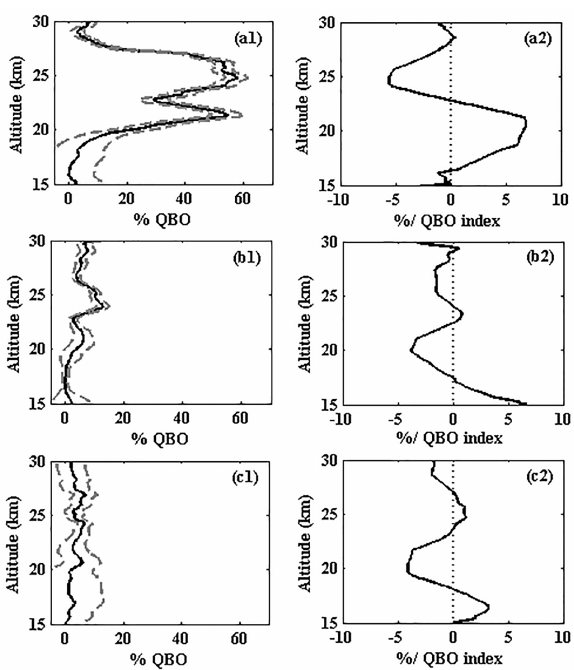
Figure 11. Height profile in % of the QBO contribution of (a1–c1) and response by unit of the QBO index (a2–c2) as calculated by the Trend-Run model over the equatorial (a1, a2) , tropical (b1, b2) and subtropical (c1, c2) regions. SDs associated with contributions are presented in grey dotted